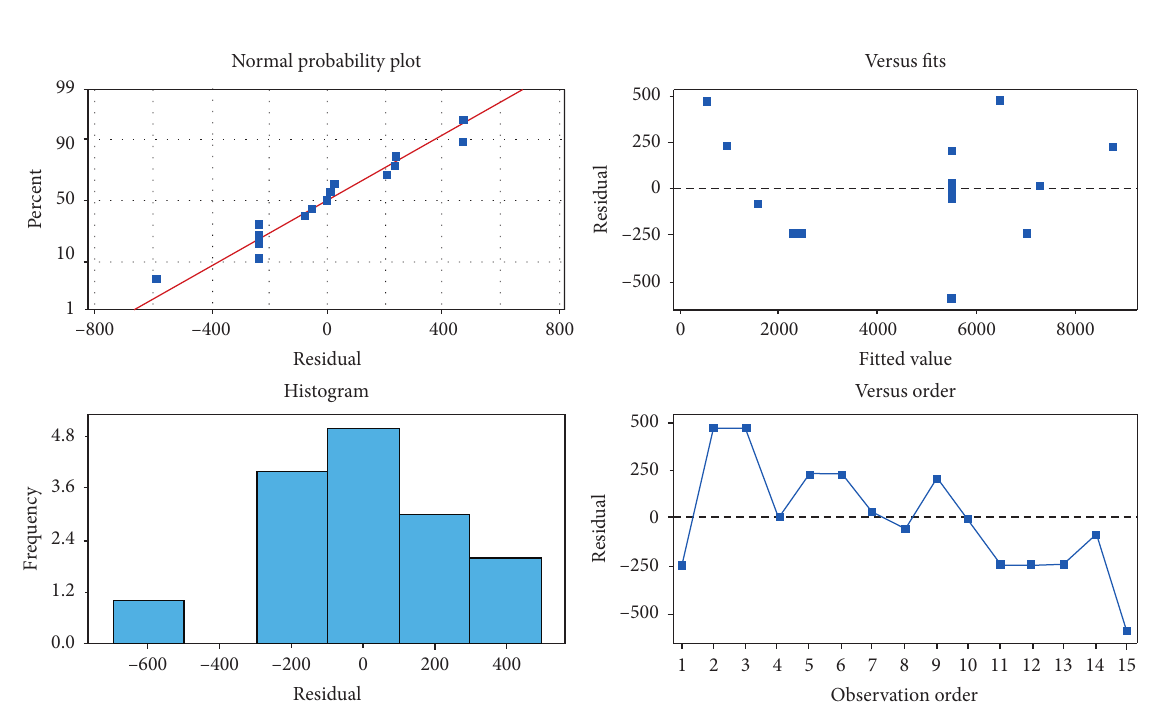
Figure 12: Residual plots for chip frequency